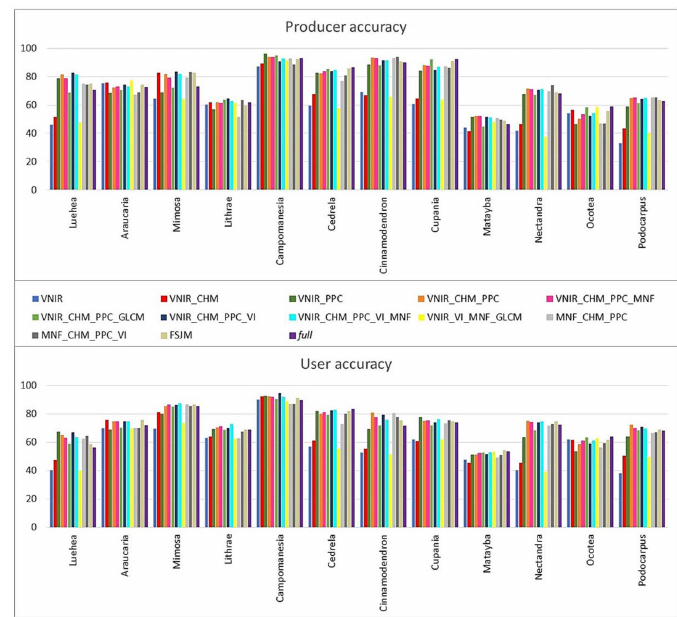
Figure 5. Producer’s and user’s accuracies of tree species classes according to the